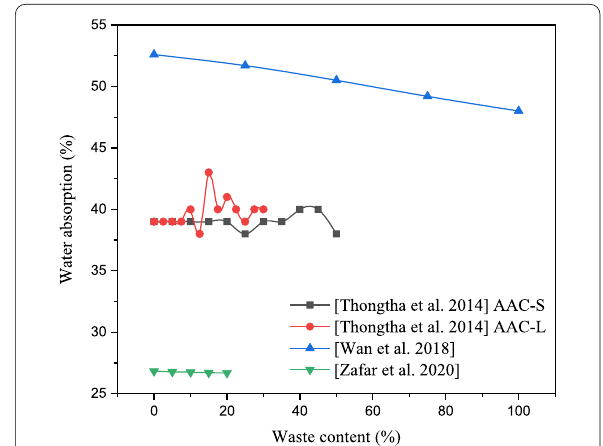
Fig. 10 Water absorption of AAC on the addition of various